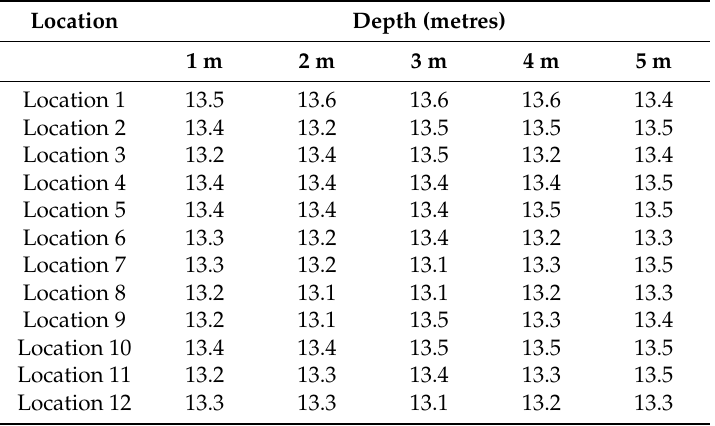
Table 4. Specific Power Dissipation per sample location and depth (W/m 3